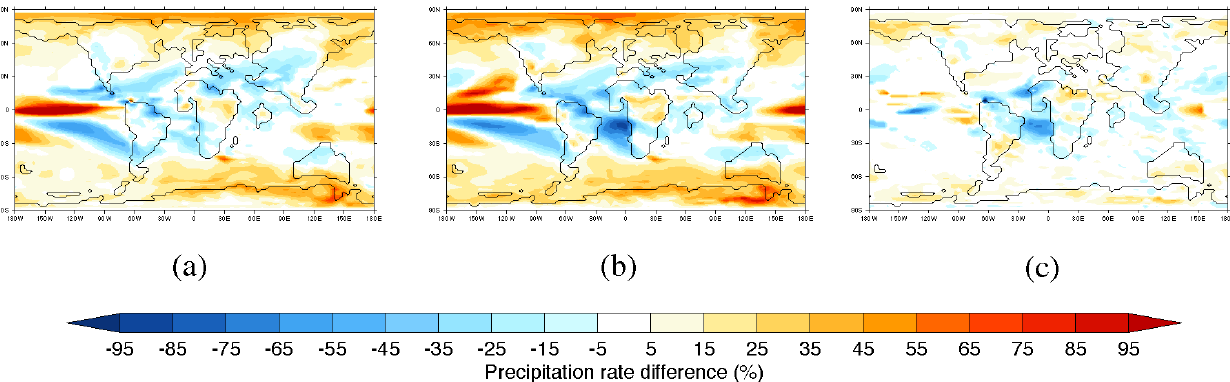
Fig. 16. Percentage change in annual precipitation between (a) 4 × SHRUB and 2 × SHRUB, and between (b) 4 × DYN and 2 × DYN, while (c) shows the effect of dynamic vegetation on the precipitation difference when CO 2 is doubled, i.e. the difference between (a) and (b) . Only differences at the 95% confidence level are